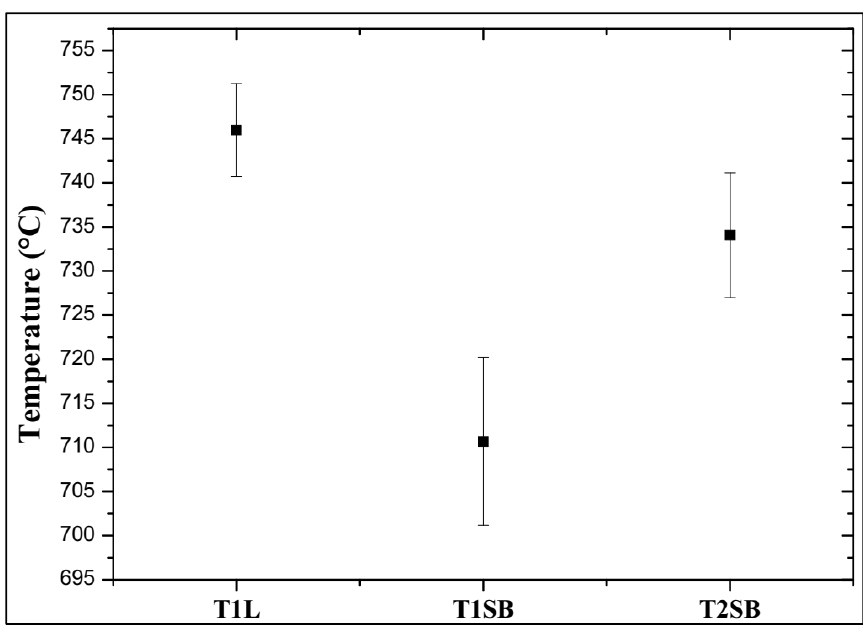
Figure 13. Maximum temperatures within the red isotherms, at different welding times (progressively advancing the torch position): T1L (linear); T1SB (switchback with F = 30 mm and B = 20 mm); T2SB (switchback with F = 10 mm and B = 5 mm).